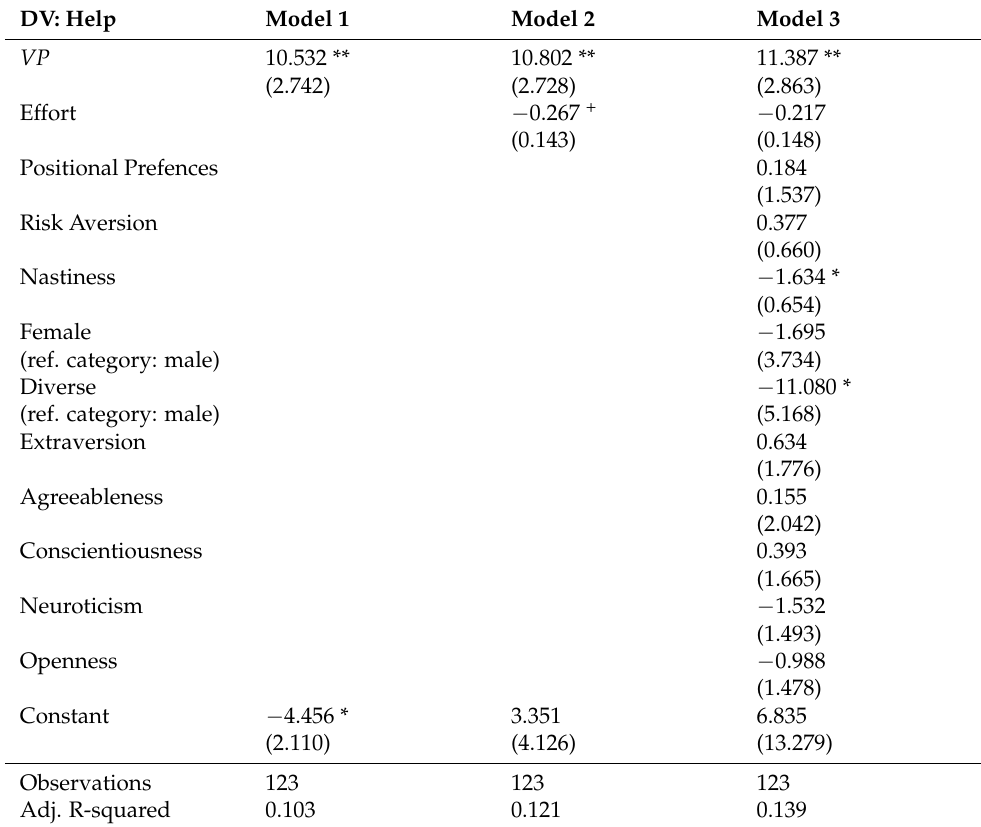
Table 6. OLS regressions for help.